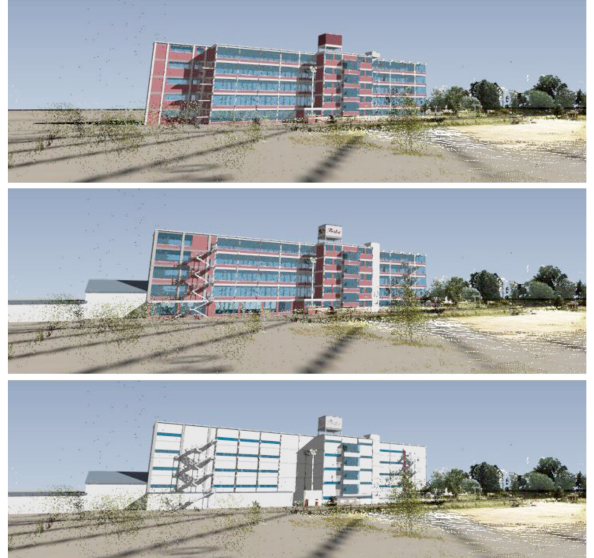
Figure 11. Factory timeline as viewed within Navisworks. (Fai et